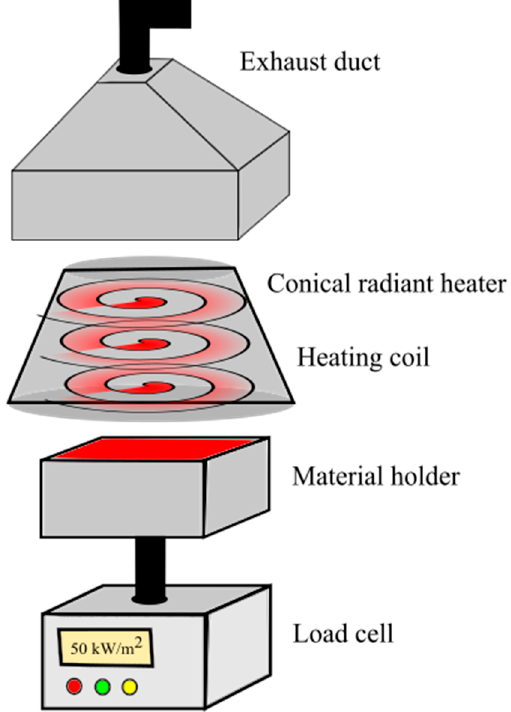
Figure 4. Fibre recovery experimental setup.